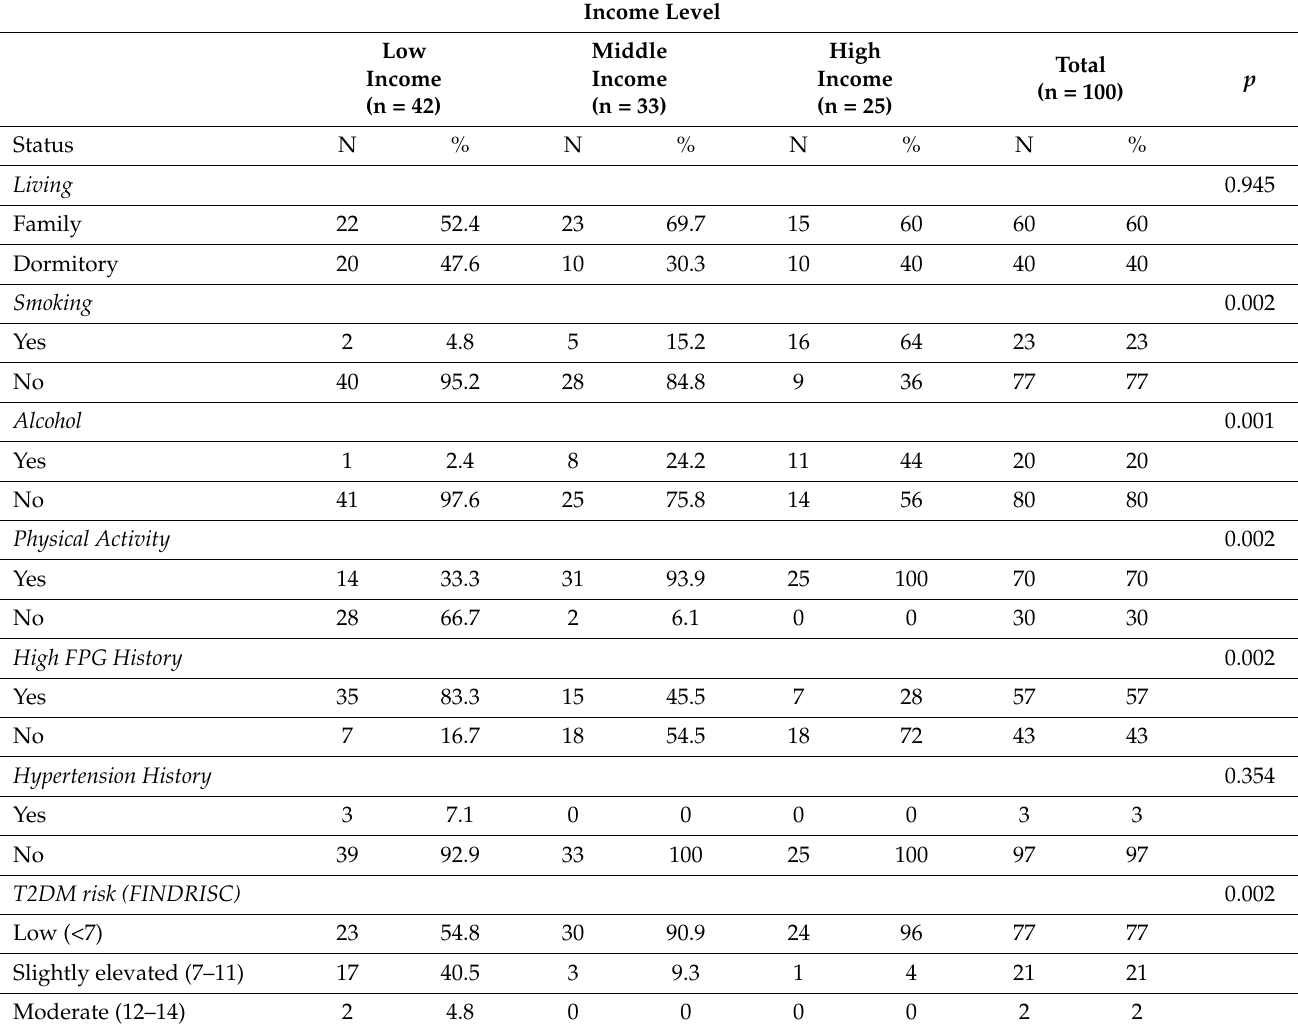
Table 3. Participant characteristics analyzed according to